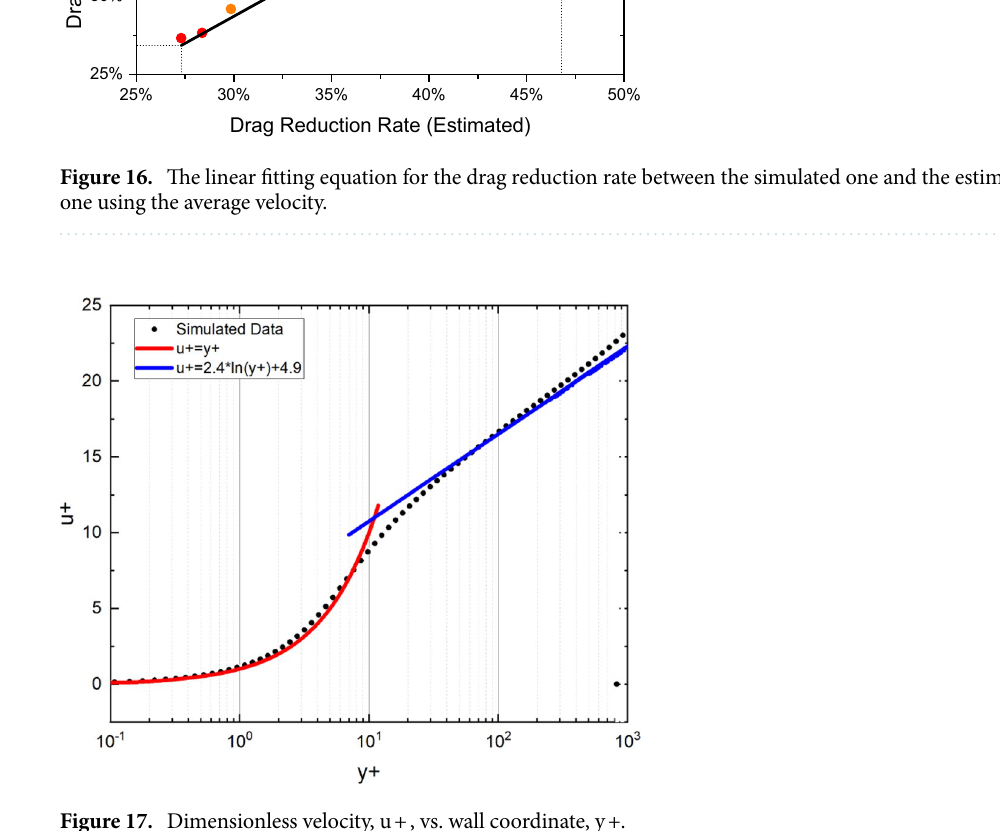
Figure 17. Dimensionless velocity, u + , vs. wall coordinate, y +.